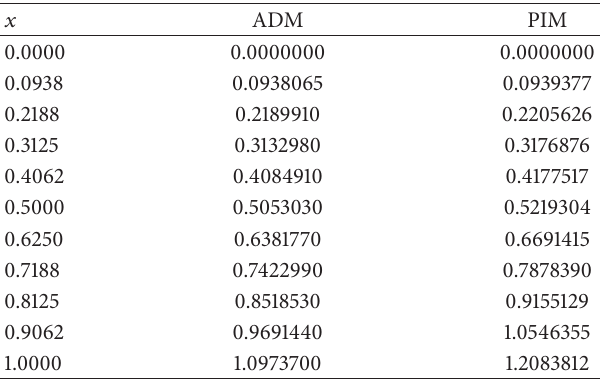
Table 2: The results of Example 2 for 𝑢 3 (𝑥) with ℎ = −1 .